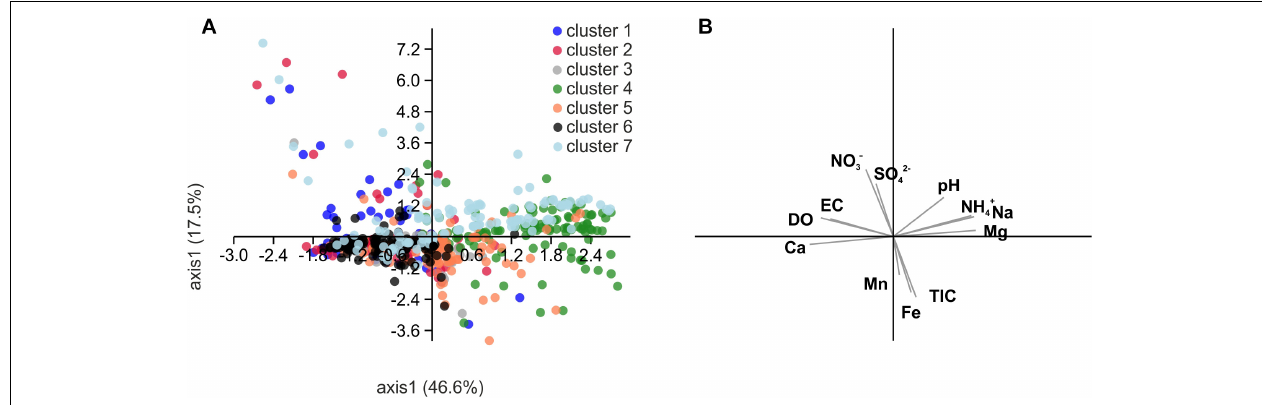
FIGURE 8 | Scatter plot derived from principal component analysis (PCA) of Spearman rank correlation coefficients of selected hydrochemical parameters with relative abundances of the OTUs included in the network of Figure 7 (A) and biplot of the correlated hydrochemical parameters (B) . To test for an effect of chemical parameters on the association of OTUs in the identified subclusters of the network, we performed pairwise correlations of relative abundances of each OTU with hydrochemical parameters and then subjected the resulting correlation coefficients of significant correlations to PCA. Correlation coefficients were calculated with relative abundances of OTUs from ten groundwater wells and one (H13, H14), two (H31) or six sampling time points per well (total n = 46). DO, dissolved oxygen; TIC, total inorganic carbon.